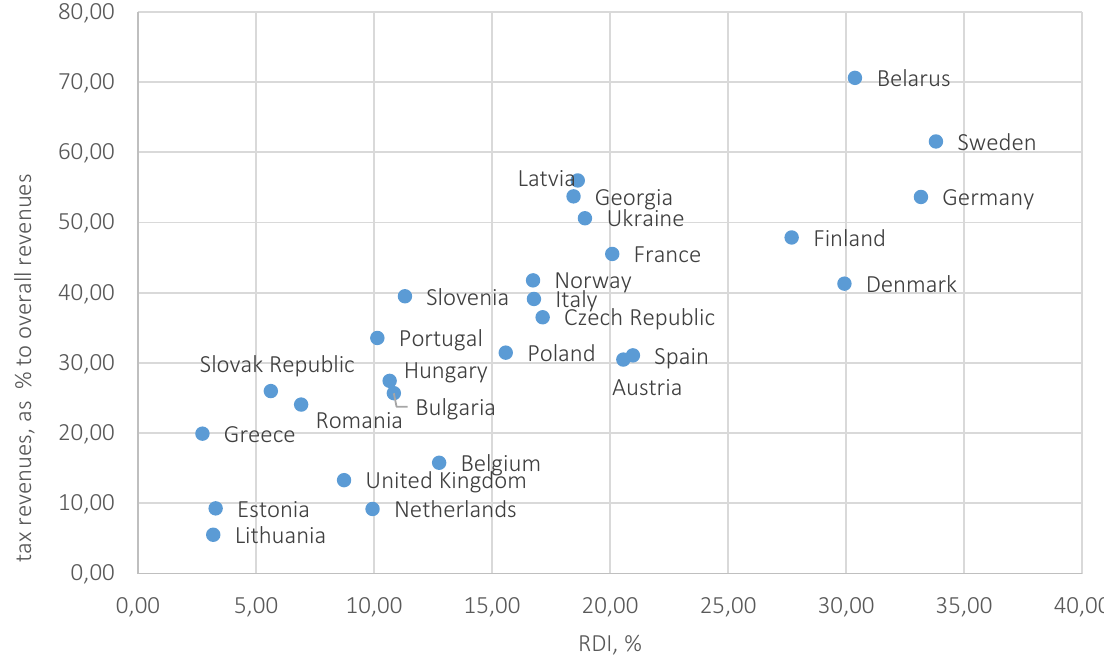
Source: Authors’ own calculation based on IMF